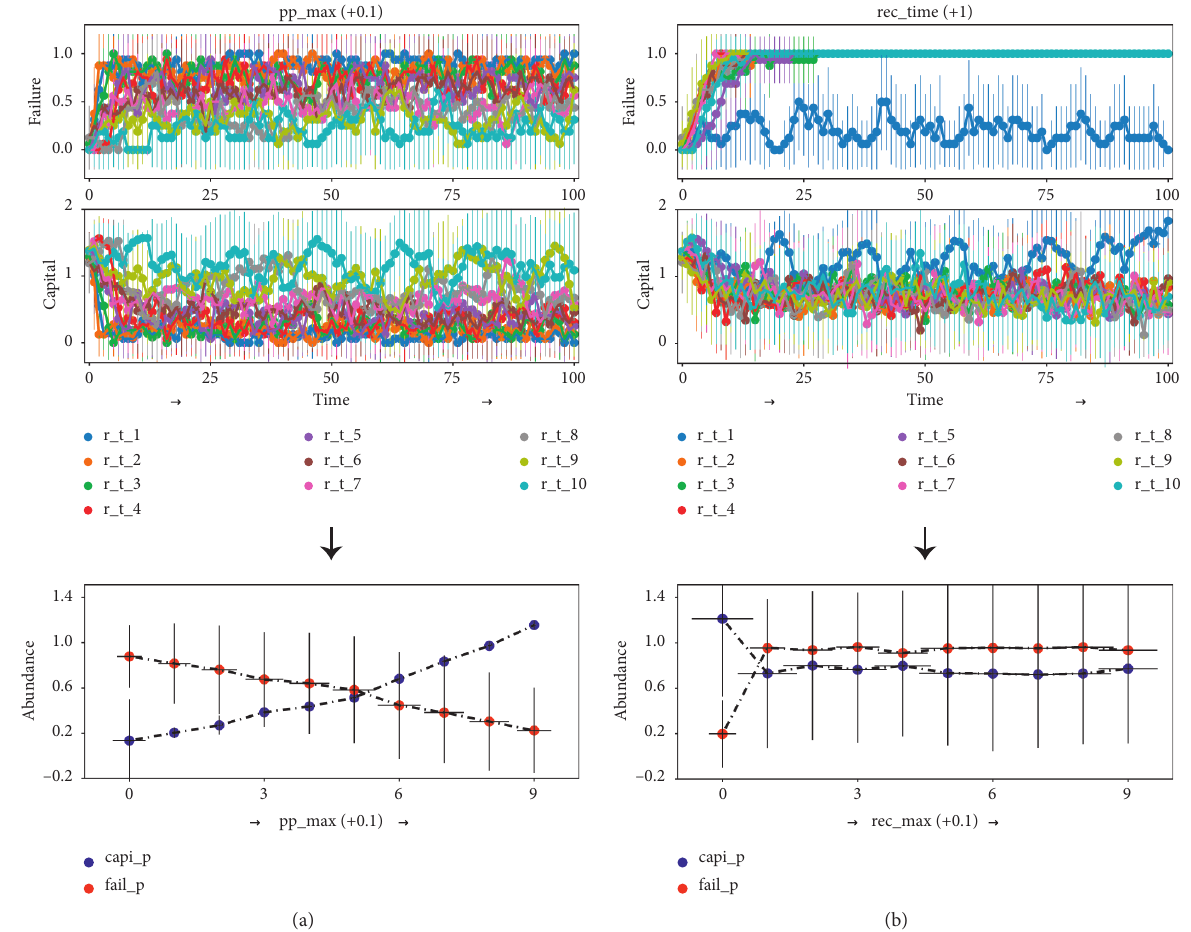
Figure 19: Representation of the outcomes according to the recovery time delay (b) and protection maximum (a). Using the same initialized parameter values (no delay [ r t � 1]), the plots represent the time delay ( r t � 1 ∼ r t � 10) case. The upper plot shows failure (vertical axis � value of the failure corresponding to the time step (horizontal axis)). The middle plot shows the capital (vertical axis � value of the capital corresponding to the time step [horizontal axis]). The lower plot shows the averaged outcome values (vertical axis) for capital and failure according to the recovery time delay (rec_time[+1]) and the protection maximum (pp_max[+0.1]) (see legend). All the dashed lines denote